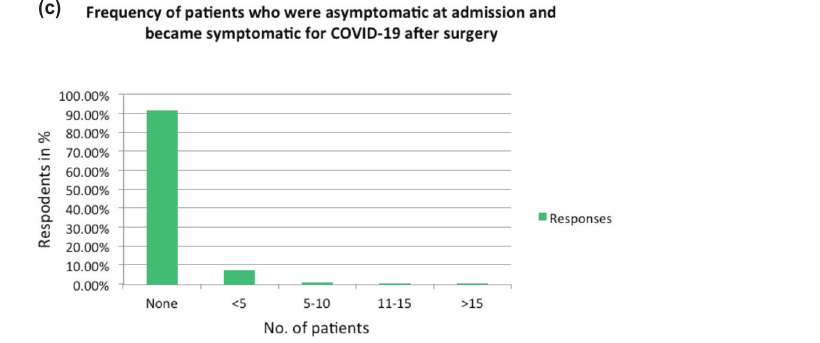
(a) Frequency of COVID-19 positive patients who underwent any orthopaedic surgery at hospitals. Frequency of COVID-19 Fig. 3: negative patients who underwent any orthopaedic surgery at hospital. Frequency of patients who were asymptomatic at admission and became symptomatic for COVID-19 after